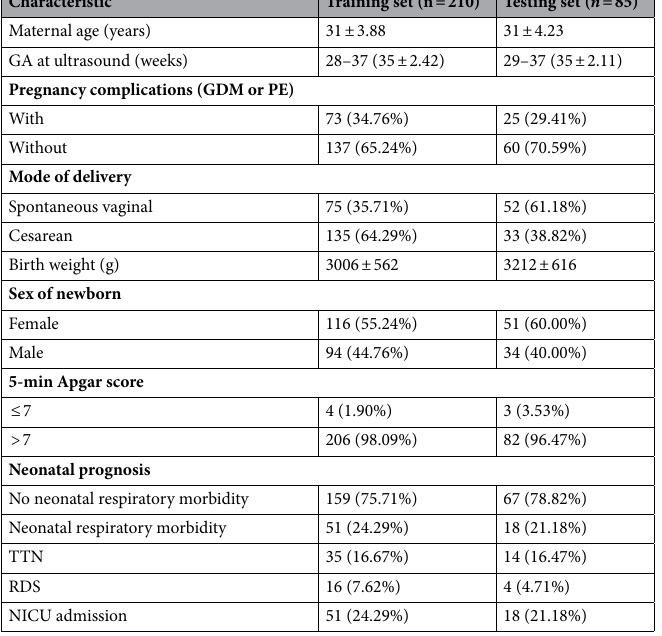
Table 1. Characteristics of study cohort. Data are presented as mean ± SD or n (%). GA gestational age, GDM gestational diabetes mellitus, PE pre-eclampsia, TTN transient tachypnea of the newborn, RDS respiratory distress syndrome, NICU neonatal intensive care